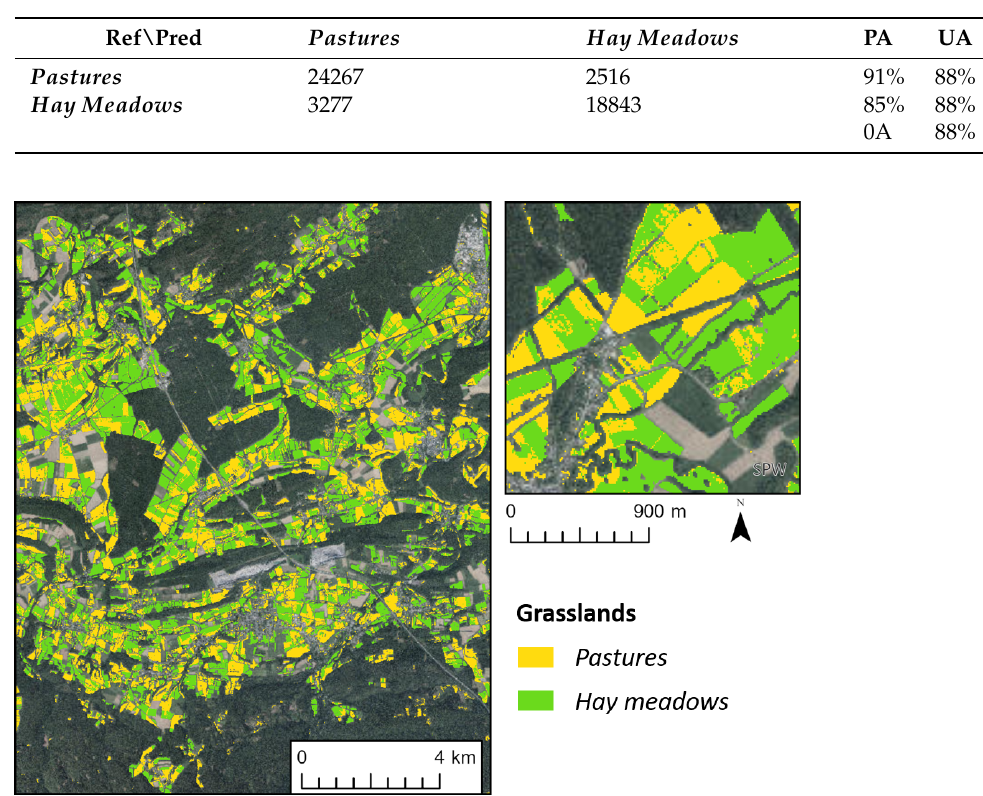
Figure 7. Pixel-based classification based on Sentinel-2 LAI time series differentiating pastures (exclusively grazed) from hay meadows (including mixed practices).